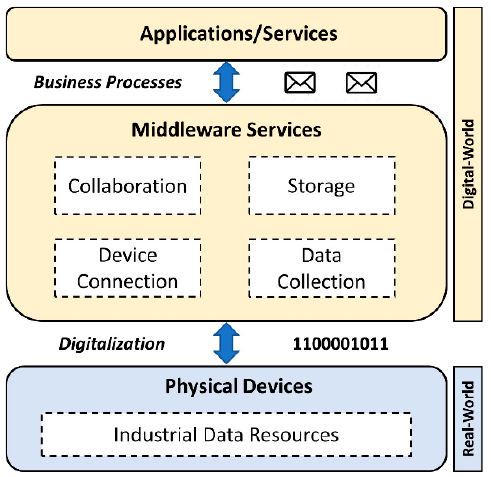
Figure 2. Industrial data